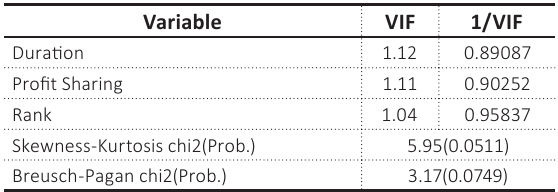
Table 2. Classical assumption testing results